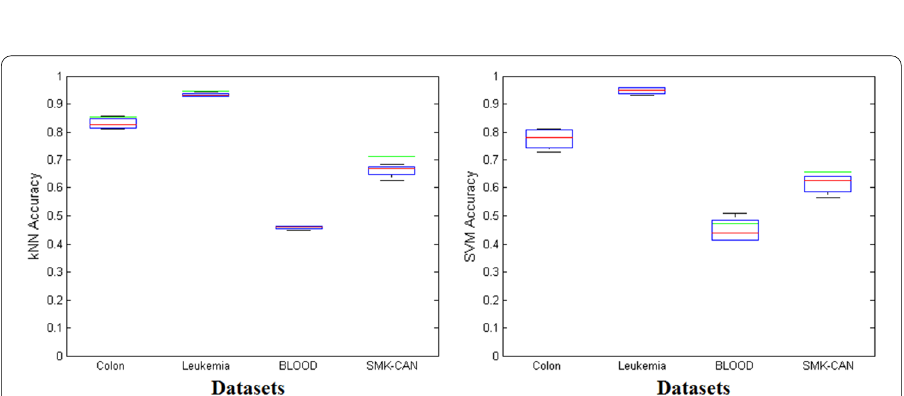
Fig. 10 Accuracy evaluation of Information Gain using KNN and SVM. Green line represents bagging while black lines, Red line and Blue box represent maximum, minimum, median and quartile of baseline performance